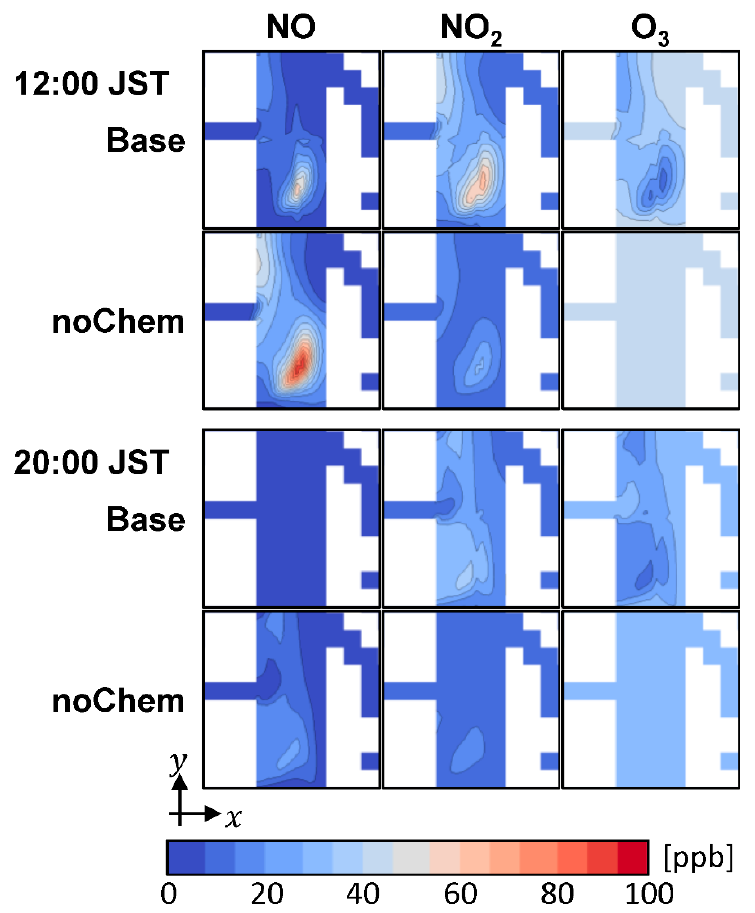
Figure 8. Pollutant concentration fields at a 3.0 m height at 12:00 and 20:00 for each case.